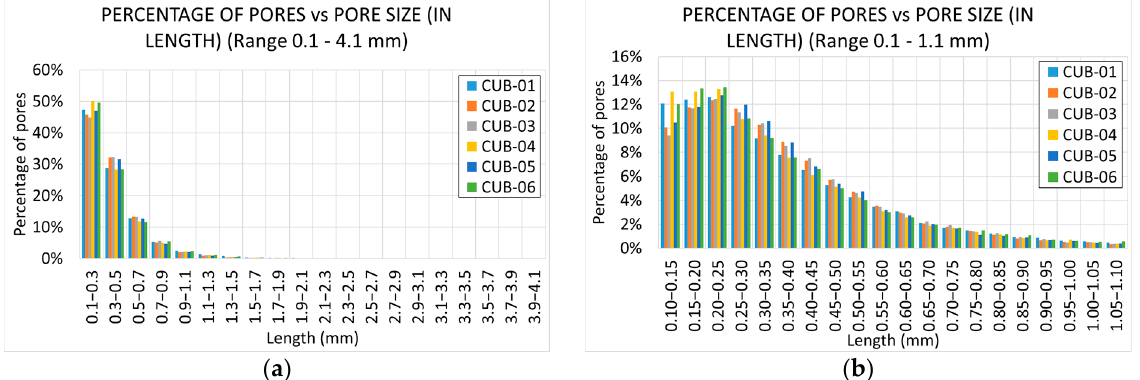
Figure 21. Histograms of pore distribution (in length) for different ranges, from the largest ( a ) to the smallest ( b ).